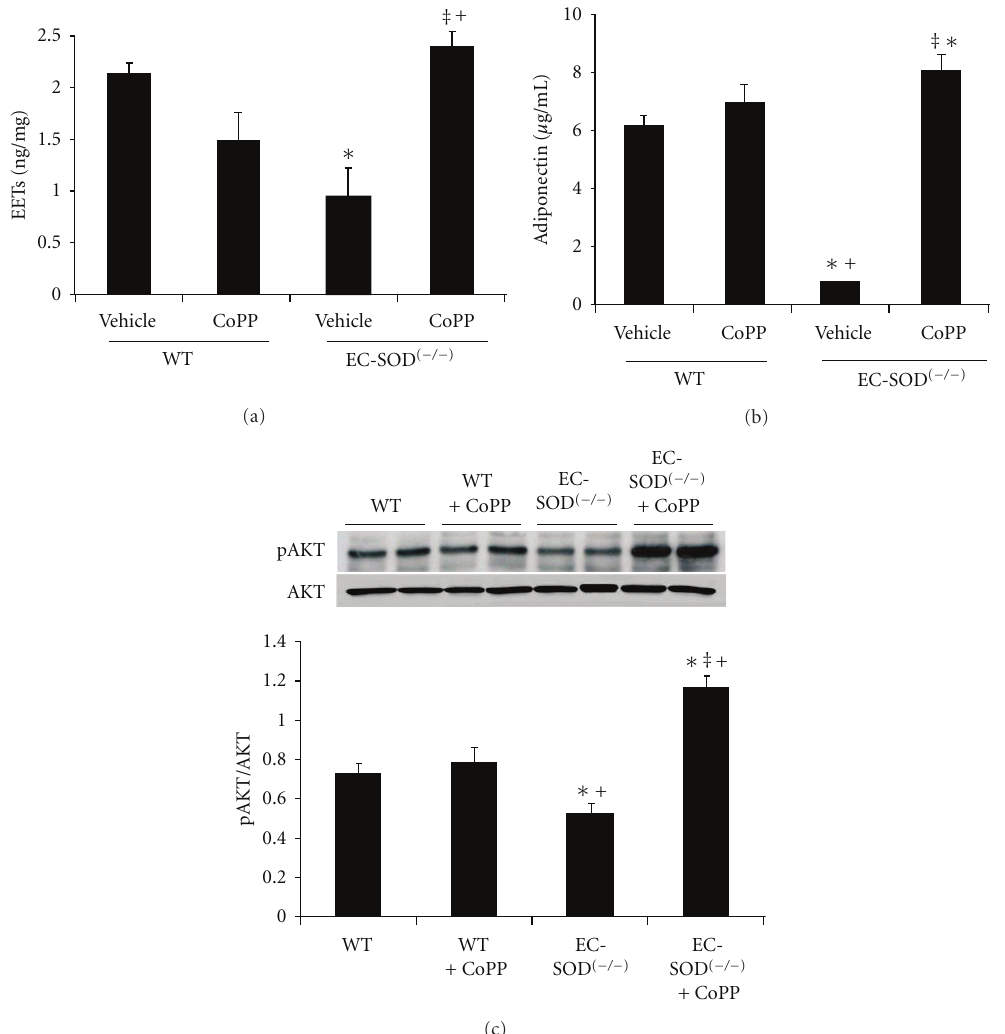
Figure 4: (a) EETs levels in WT and EC-SOD ( − / − ) mice and mice treated with CoPP. EETs levels were determined as described in Methods. Results are mean ± SE, n = 4; ∗ P < 0 . 05 versus WT mice, ‡ P < 0 . 05 versus EC-SOD ( − / − ) and + P < 0 . 05 versus WT + CoPP mice. (b) Adiponectin levels in WT and EC-SOD ( − / − ) mice and mice treated with CoPP. Adiponectin levels were determined as described in methods. Results are mean ± SE, n = 4; ∗ P < 0 . 05 versus WT mice, ‡ P < 0 . 05 versus EC-SOD ( − / − ) mice, and + P < 0 . 05 versus WT + CoPP mice. (c) AKT and pAKT proteins in arteries of WT and EC-SOD ( − / − ) mice. Mice were injected with CoPP once a week as described in Methods. Blots are representative of four separate experiments. Results are expressed as mean ± SE, ∗ P < 0 . 05 versus WT, ‡ P < 0 . 01 versus EC-SOD ( − / − ) , + P < 0 . 05 versus WT + CoPP